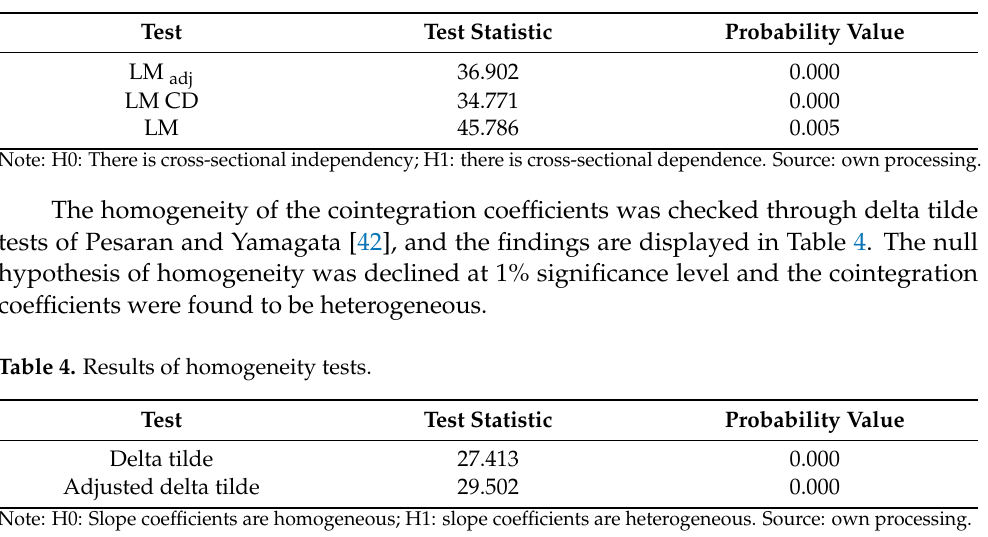
Table 3. Results of cross-sectional dependency tests.